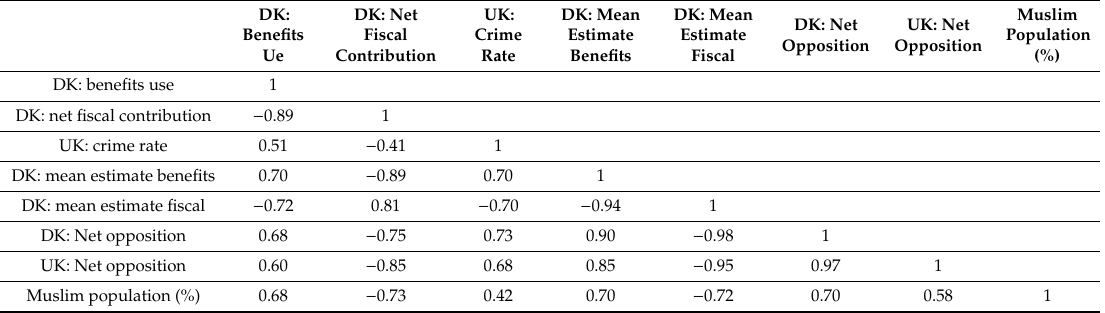
Table 4. Primary variables across Danish and British datasets. DK = Denmark. UK = United Kingdom. ‘Benefits use’ is the proportion of people aged 30–39 who were receiving social benefits in Denmark in 2012. ‘Net fiscal contribution’ refers to each origin country group’s net fiscal contribution in Denmark in 2014, according to the Danish Ministry of Finance. ‘Crime rate’ is the crime rate (see text for calculation), taken from Carl [5]. ‘Mean estimate benefits’ is the mean estimate of benefit use (as defined above), taken from Kirkegaard and Bjerrekær [6]. ‘Mean estimate fiscal’ is the mean estimate of net fiscal contribution from the present study. ‘Net opposition’ is the average net opposition, taken from Carl [5] and from the present study. ‘Muslim population (%)’ is from Pew Research’s 2010 estimates, augmented with estimates for a few missing